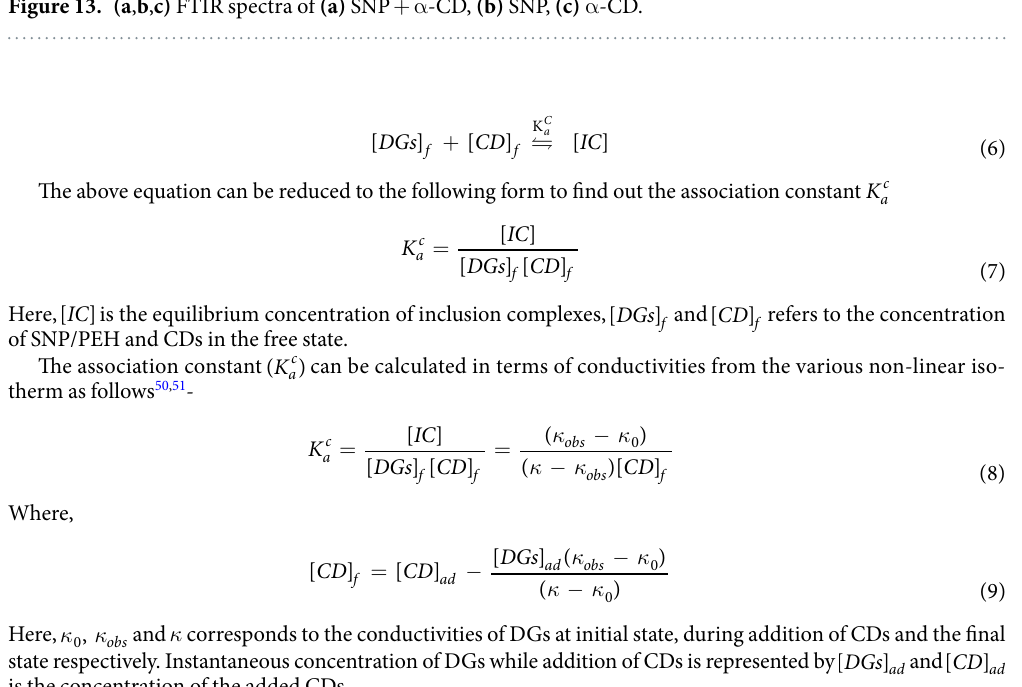
Figure 13. (a , b , c) FTIR spectra of (a) SNP + α -CD, (b) SNP, (c) α